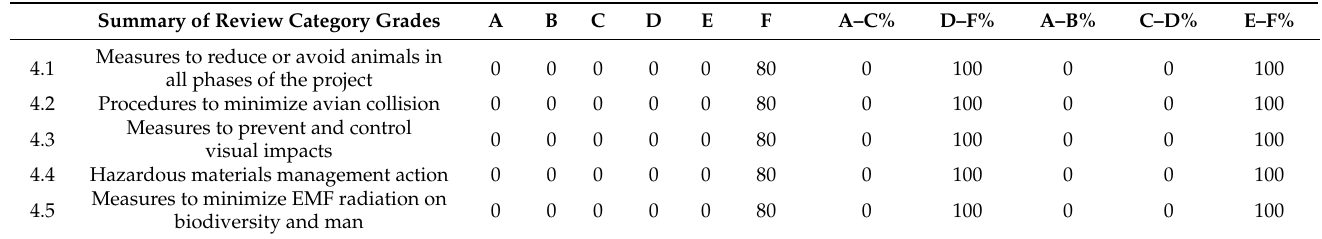
Table 8. Allocation of quality to environmental assessment tasks performed under Review Area 4.